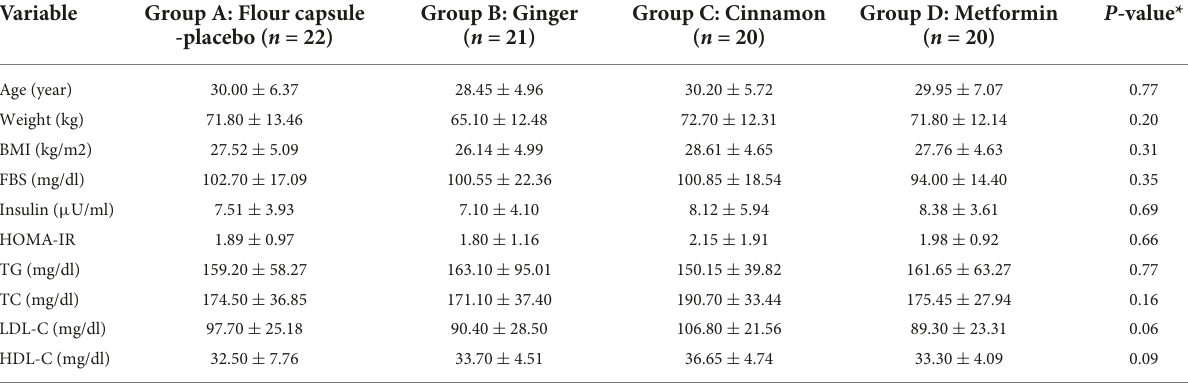
TABLE 1 Baseline characteristics of the participants.